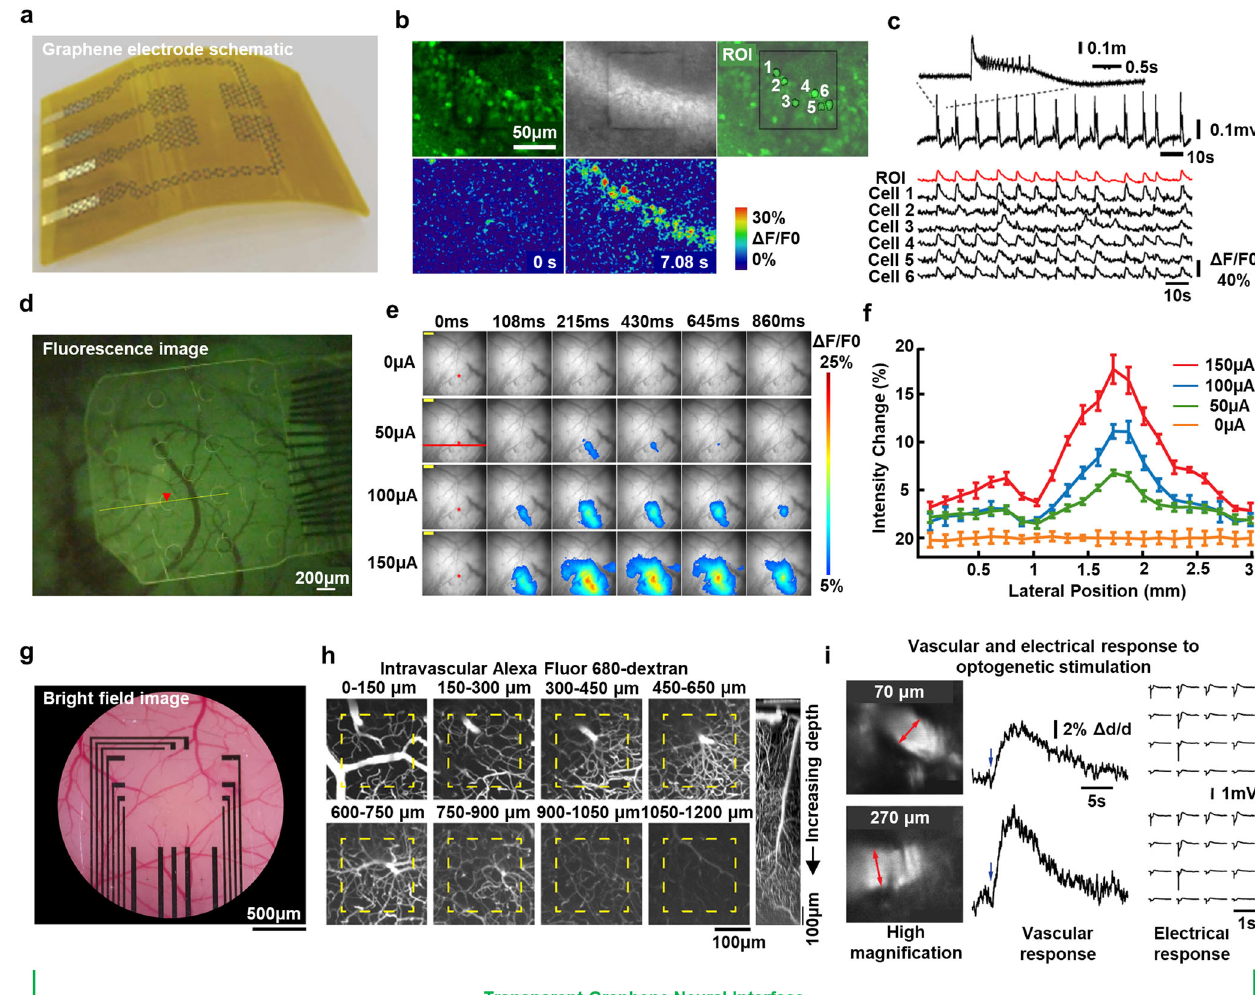
Fig. 4 Graphene-based transparent electrode array for simultaneous electrical and optical modalities. a Schematic of a graphene-based transparent neural interface. The honeycomb-lattice structure of graphene maximizes electrode transparency. b Calcium transient images under a graphene-based transparent electrode with 488 nm excitation wavelength. Six cells are numbered in the region of interest. Scale bar: 50 µm. c Correlation between electrophysiological signals re fl ecting manually induced interictal-like effects (top) and simultaneous Δ F/F0 curves for numbered cells in panel b (bottom). All data from panels b and c are observed simultaneously. d Fluorescence image of a GCaMP6f mice cortex under a transparent graphene electrocorticography (ECoG) array. Scale bar: 200 µm. e Spatiotemporal fl uorescence recordings with various electrical stimulation amplitudes. f Plot of intensity changes versus the lateral position. The greatest intensity changes were detected at the stimuli point (between 1.5 and 2 mm). The lateral position axis corresponds to the horizontal red line in panel e . g Bright optical image of the transparent graphene electrode array on the brain surface. Scale bar: 500 µm. h Two-photon imaging at a depth of 1,200 µm under photoelectric artifact minimized graphene electrode. Scale bar: 100 µm. i Crosstalk-free detection of two-photon imaging and electrophysiological recording, according to simultaneous optogenetic stimulation. Panel a, b, and c adapted from ref. 24 , Springer Nature Limited. Panel d, e, and f adapted with permission from ref. 15 , American Chemical Society. Panel g, h, and i adapted from ref. 109 , Springer Nature between fl uorescence transients and electrophysiological signals transparency, a similarity between calcium imaging and electro- using transparent graphene electrodes. physiological signals was veri fi ed. Figure 4a shows a schematic In general, graphene-based transparent neural interfaces illustration of a transparent neural interface using graphene. The requires a high quality graphene but the transfer process of the transparency of the electrode is owing to the honeycomb-lattice graphene on a subtrate make the fabrication complexity. In structure of graphene as we can see in the fi gure 24 . Figure 4b addition, light absorption and dissipation by the substrate site are illustrates fl uorescent calcium images under the graphene critical in optical modalities. To maximize transparency of the electrode on a P12 mouse hippocampal slice using a 488 nm electrode, a Parylene C and graphene-based transparent electrode excitation wavelength. Modi fi cation of ion concentrations, such as was fabricated. A fl uorescence image using the device is shown in potassium and magnesium ions, and bicuculline-methiodide were Fig. 4d 15 . Charge density limitation for the four-layer graphene utilized to make spiking activities of the sample. Simultaneously, electrophysiological signals were recorded by the electrodes electrode was characterized based on EIS, CV, and a failure bench- without noticeable laser-induced artifacts, and it is shown testing method. Spatiotemporal responses with varying stimula- together, as illustrated in Fig. 4c, with calcium transients of the tion currents in the calculated range (approximately 150 μ A) numbered cell. This implies that a strong correlation exists veri fi ed the correlation between the stimulation current and